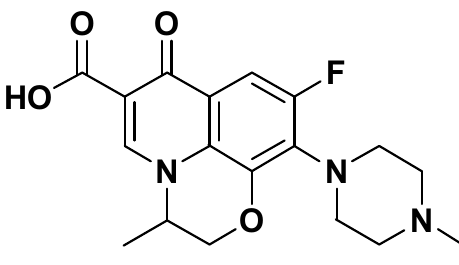
Figure 1. Structure of ofloxacin (OFL) drug.